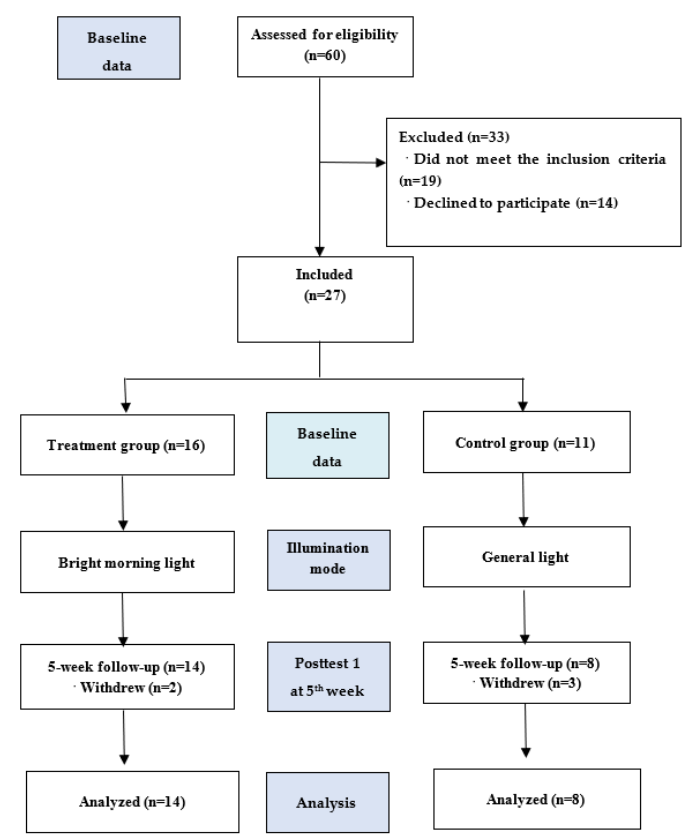
Figure 1. Flow chart of participant recruitment.